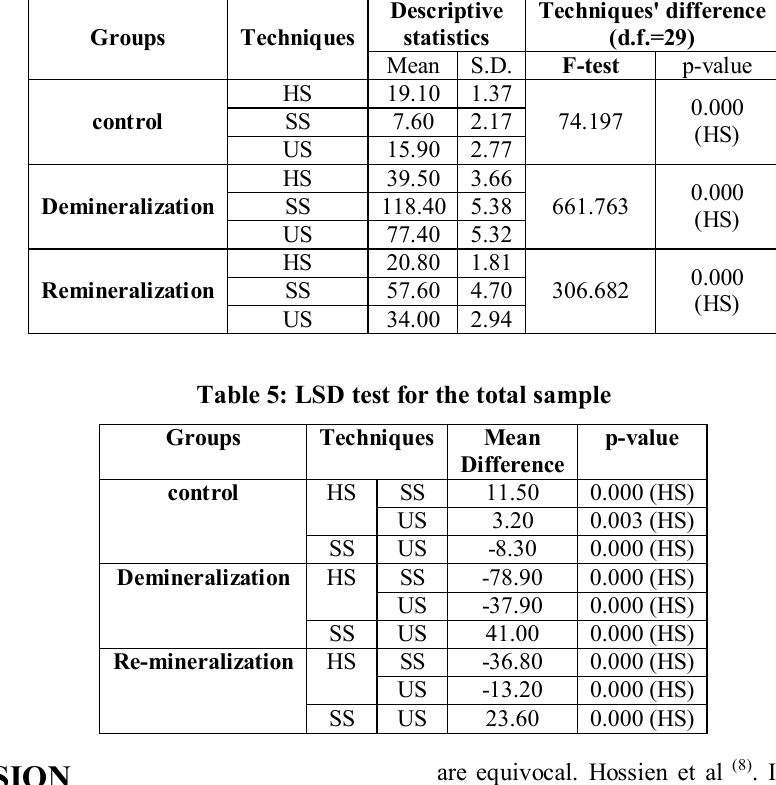
Table 4: Enamel damage depth (μm) using different adhesive removal techniques Groups